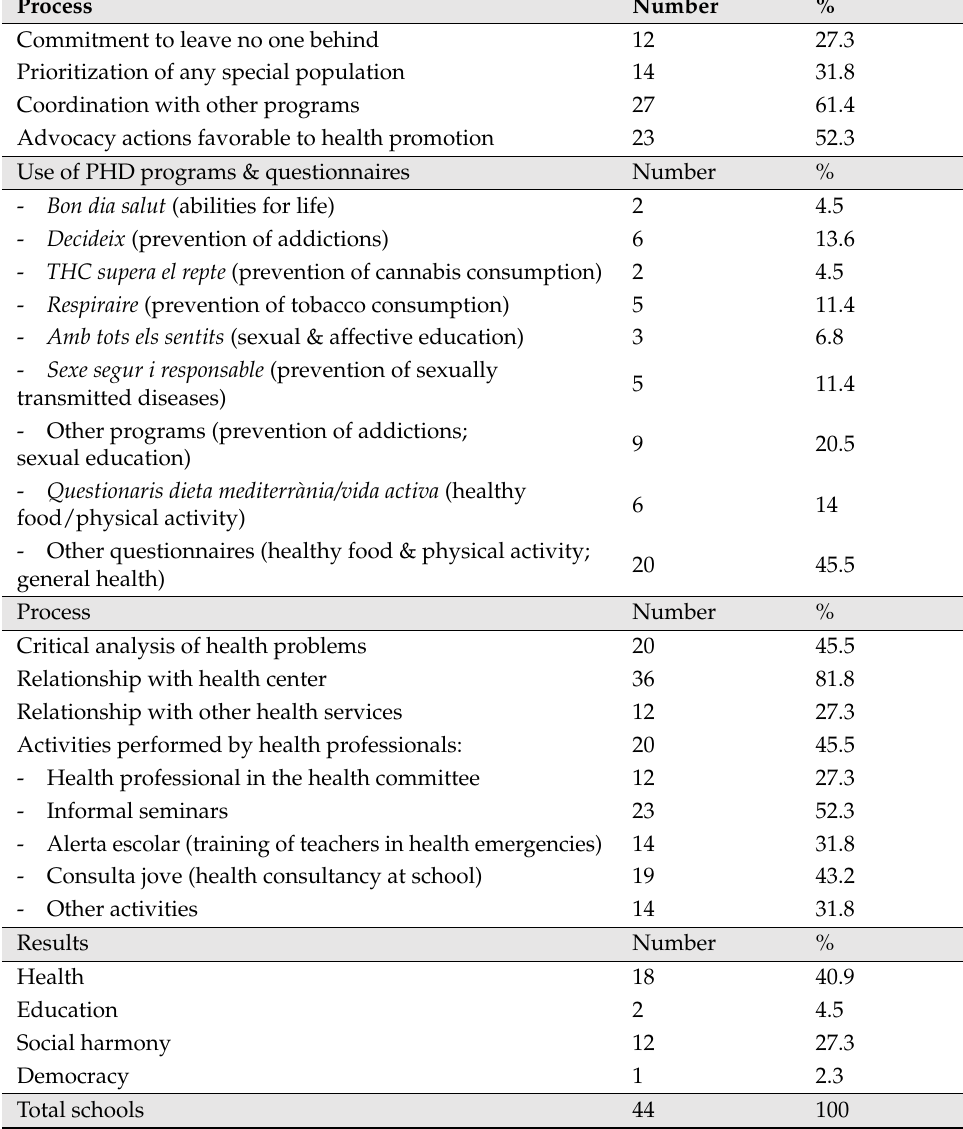
Table 2. Process and results evaluation of the CEPS Program (N = 44)